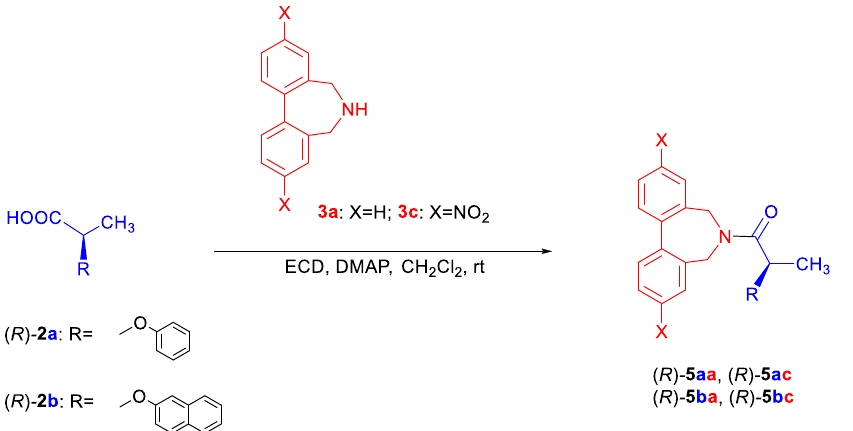
Arylpropionic Acid a ( S )-1b